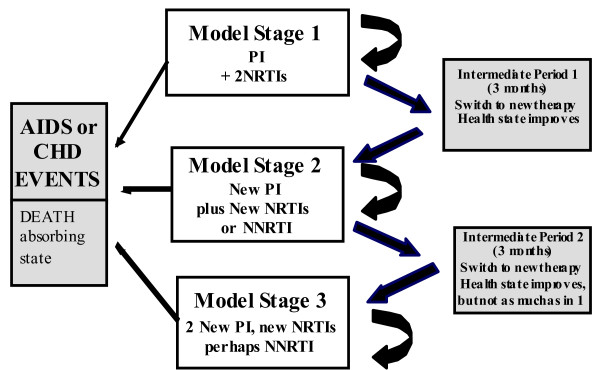
Model Structure.